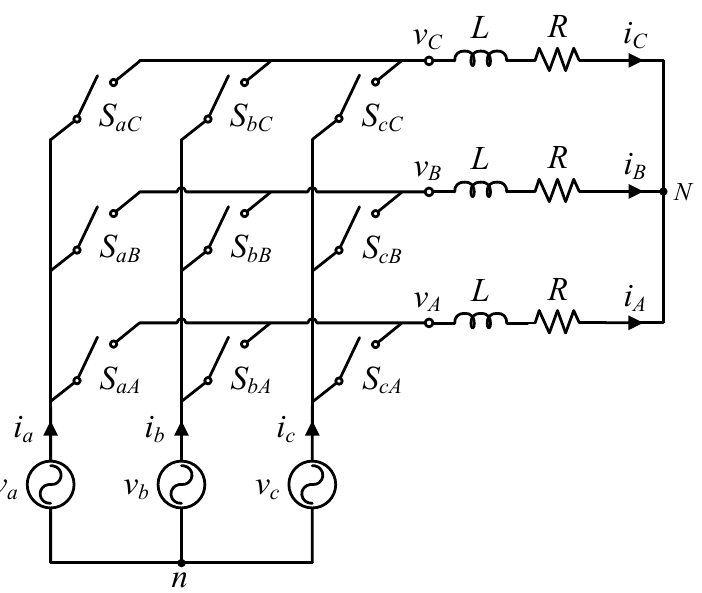
Figure 14. Power circuit of the DMC modeled for simulation.